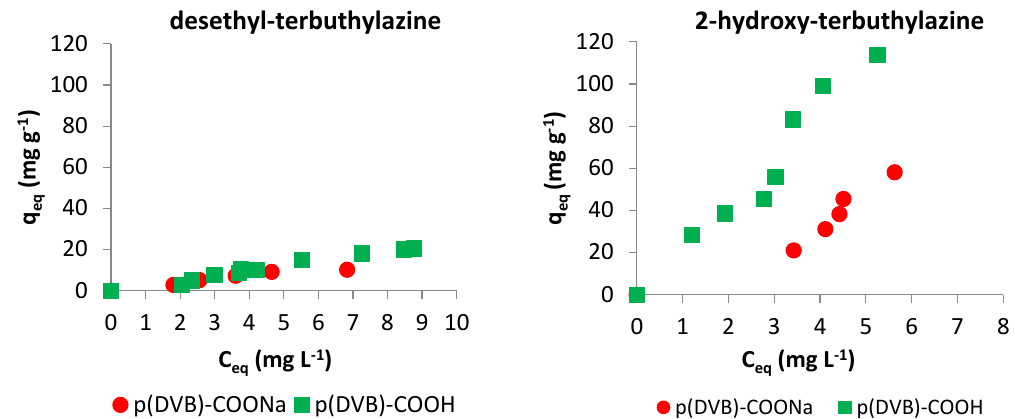
Figure 5. Adsorption isotherms for desethyl-terbuthylazine and 2-hydroxy-terbuthylazine on microspheres having carboxyl